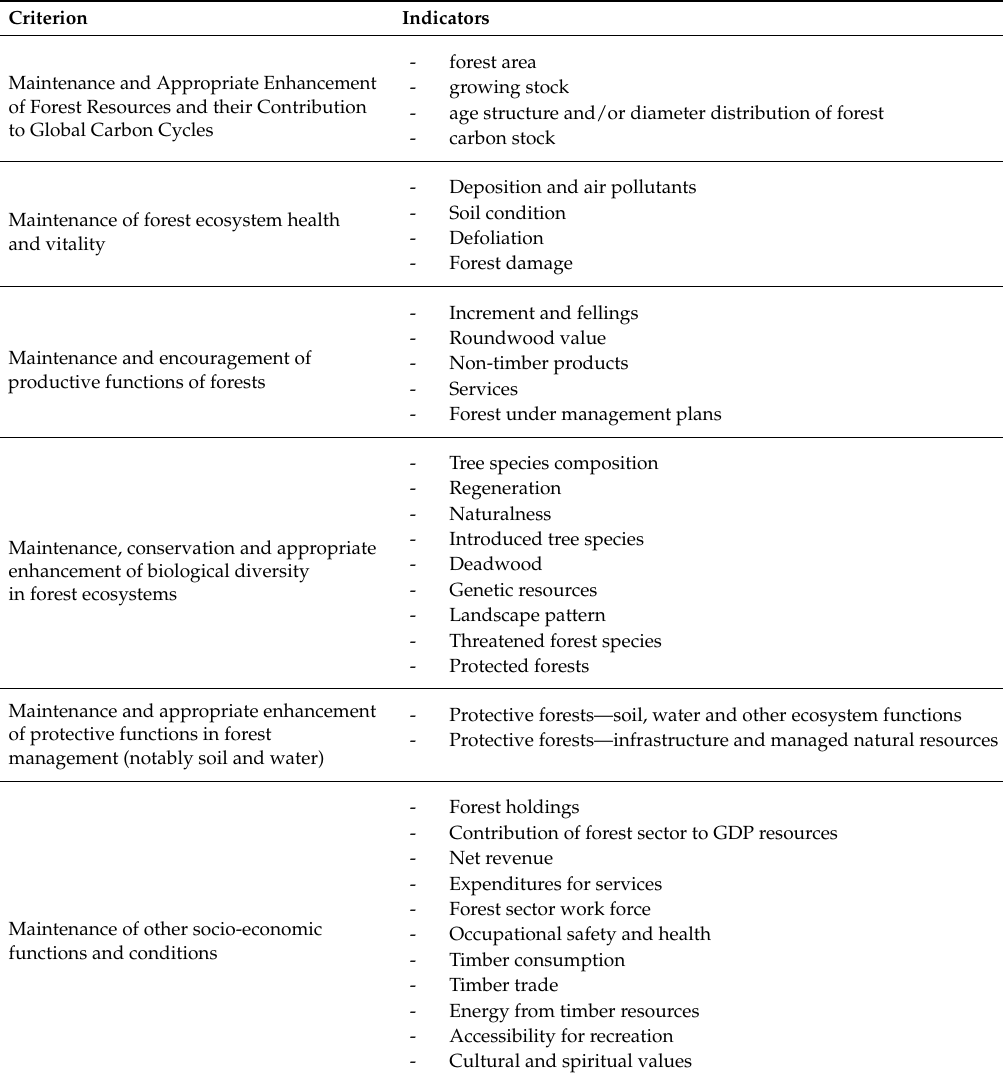
Quantitative indicators used by the 7th FOREST EUROPE Ministerial Conference, in October 2015. Source and modified after the United Nations Report “State of Europe’s Forests 2015”. FOREST EUROPE, 2015: State of Europe’s Forests